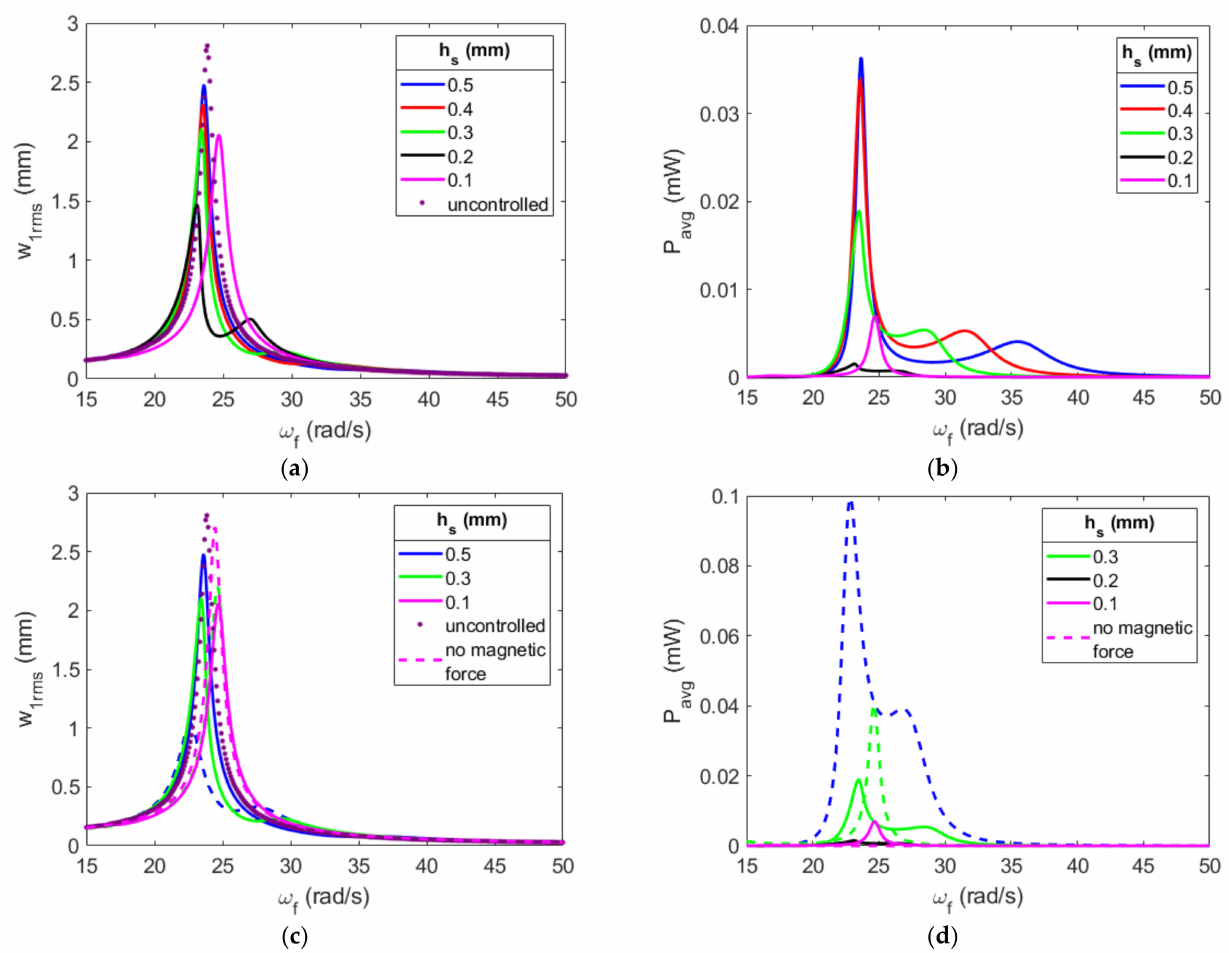
Figure A3. The effects of varying substrate thicknesses with a tip mass of 0.04 kg and an initial gap of 7.5 mm on the amplitude of the ( a ) primary structure and ( b ) absorber, as well as a comparison with configurations with no magnets ( c , d